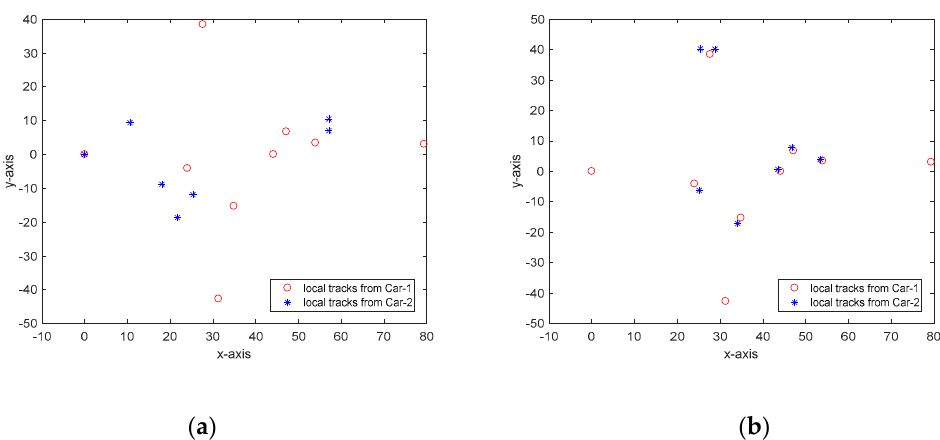
Figure 10. Illustration of local tracks from Car-1 and Car-2 at time step 𝑘 = 50 . ( a ) Before association; ( b ) After association.